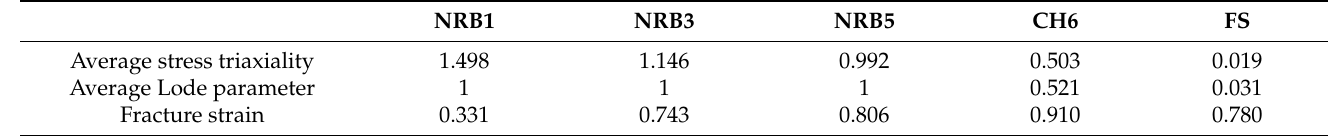
Table 2. Average stress triaxiality, Lode parameter, and fracture strain of each specimen.